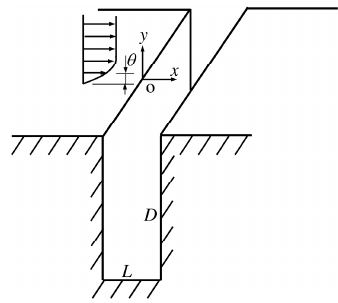
Figure 1. Configuration of the flow over a cavity.